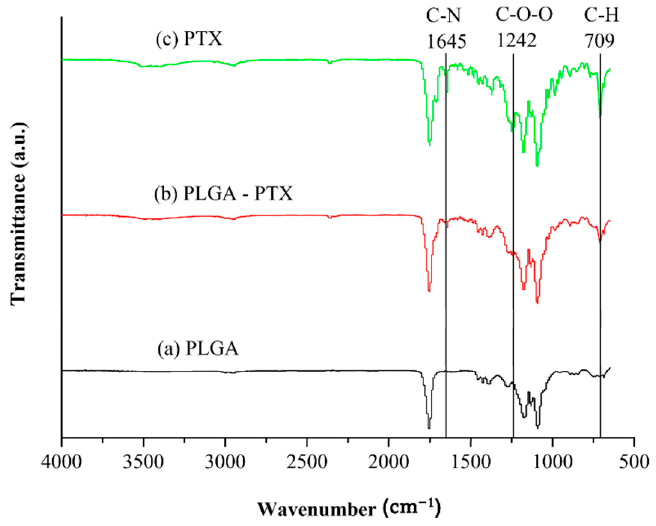
Figure 2. FTIR spectra of ( a ) PLGA, ( b ) PLGA-PTX nanofibers, and ( c ) pure PTX.